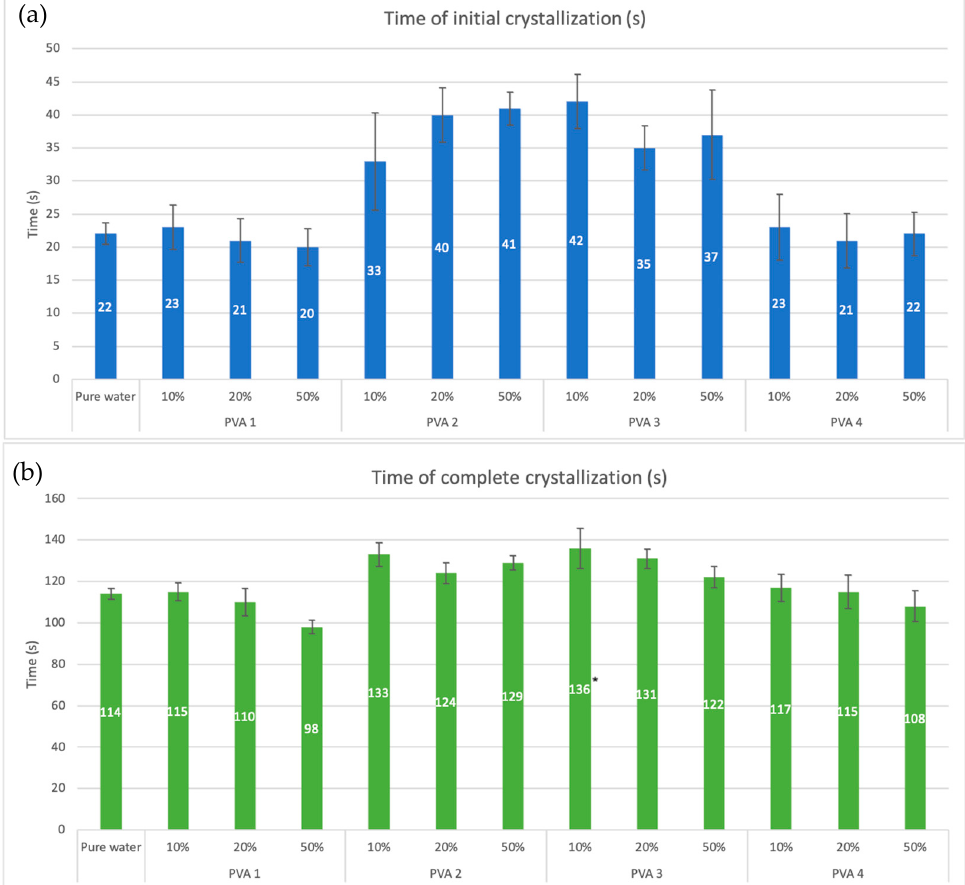
Figure 4. ( a , b ). Initial ( a ) and complete ( b ) crystallization times for pure water and PVA samples 1–4 with 10%, 20%, and 50% mass content. Note: * indicates that approximately 3 mm of the top portion of the samples in the test tube remained liquid even after the remainder of the sample was completely frozen.